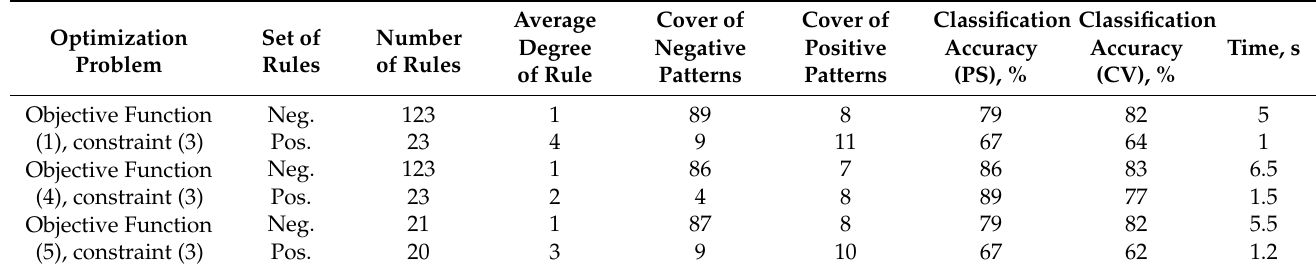
Table 2. Classification results for the problem of predicting the outcome of a patient’ disease with hepatitis.